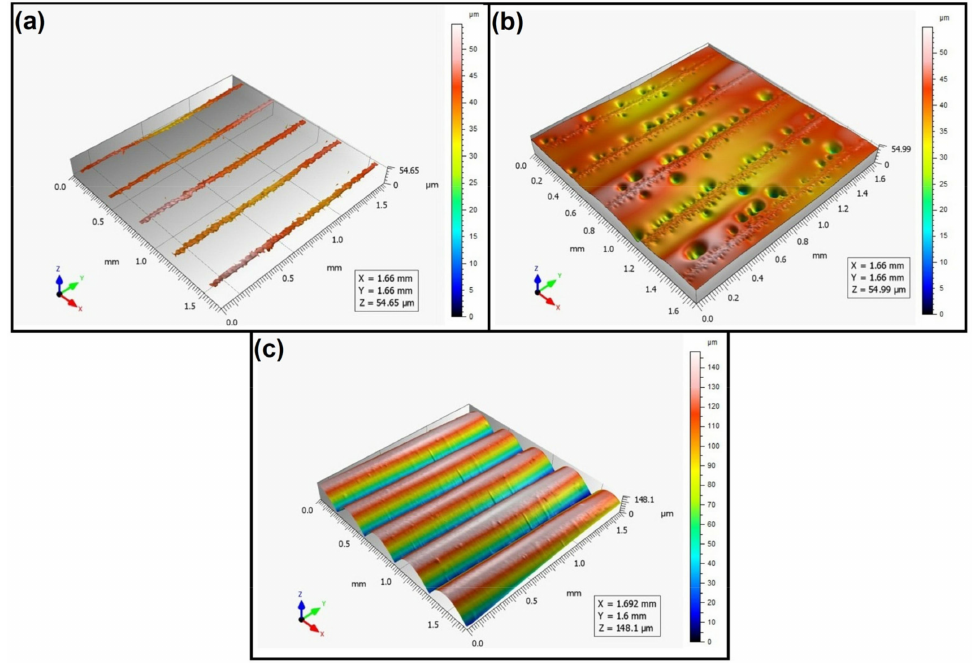
Figure 7. Surface topography of the element 3D printed using FDM technology (Pd = 45 ◦ ). ( a ) Talysurf CCI—without filling non-measured points, ( b ) Talysurf CCI—after filling non-measured points, ( c ) Talysurf PGI